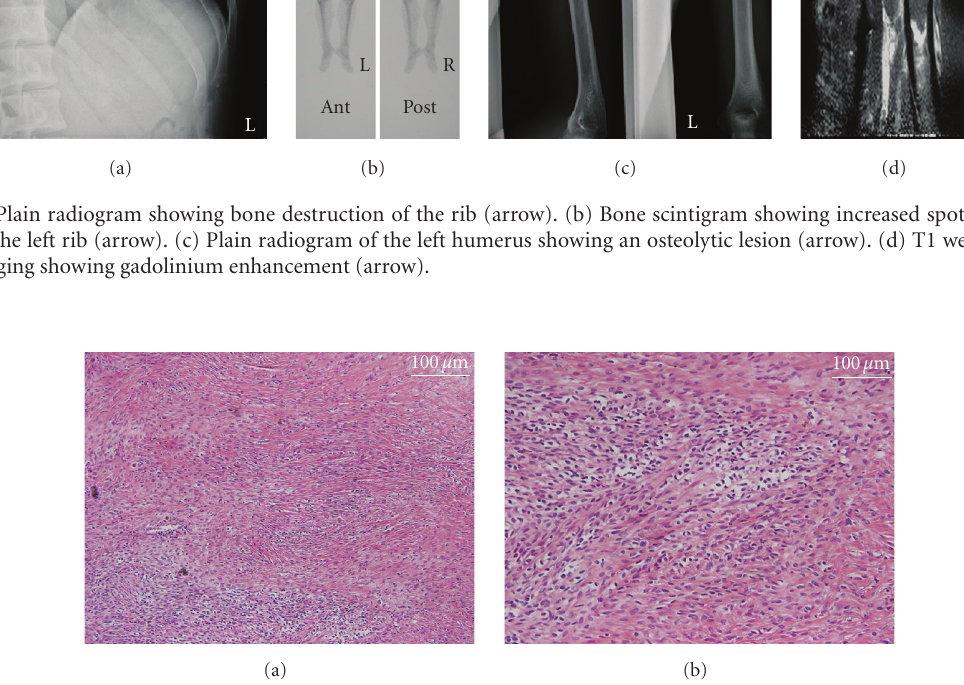
Figure 2: the specimen of the abdominal tumor excised in 1995 showing abundant collagen proliferation (a) and alveolar pattern (b).